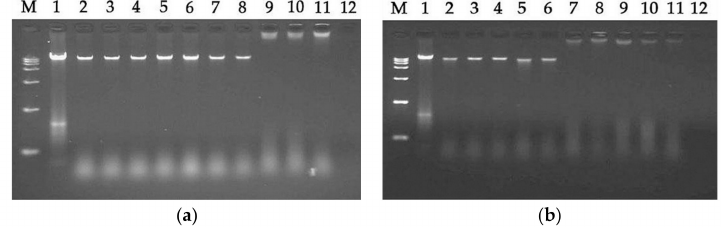
Figure 7. A gel retardation experiment was used to measure the DNA binding assay: ( a ) LR pG -treated; ( b )LR α -treated. M:DNAmarkeralone; 1: genomicDNAalone; 2: with0.5 µ Mpeptide; 3:with1 µ